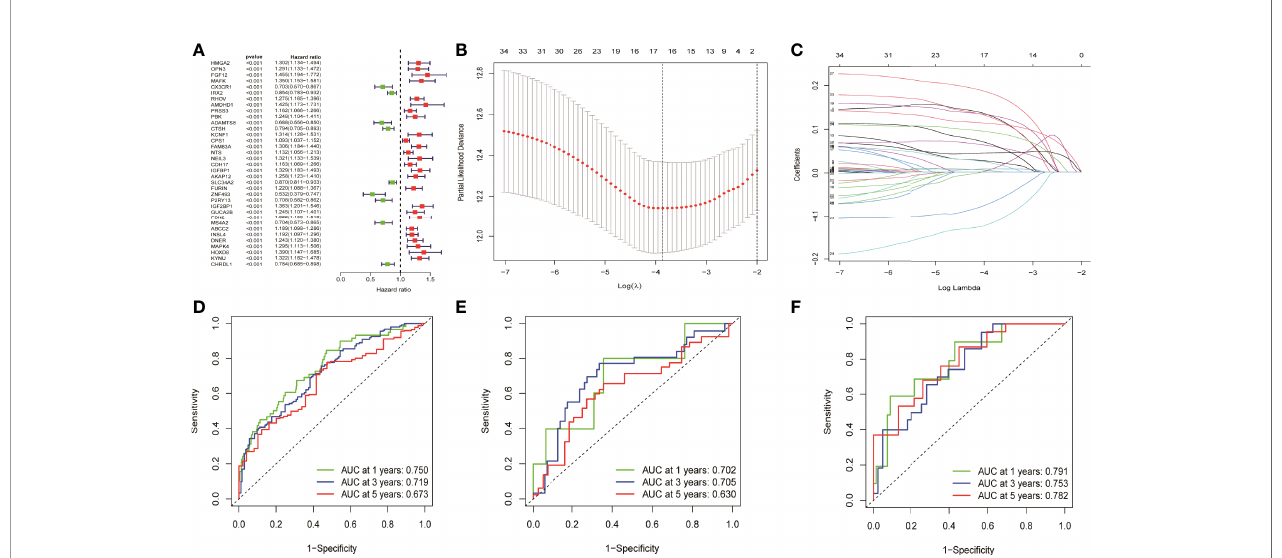
FIGURE 2 | Univariate cox analysis andLASSO regression constructed and veri fi ed the prognosticmodel. (A) Thirty fi ve prognosticgenes were screenedby univariate cox analysis. (B, C) LASSO regression removed the redundancy factors andconstructed a prognostic model with 16 genes. (D – F) The ROC curves ofTCGA LUAD, GSE42127, andGSE68571 veri fi edthe reliability of the model.